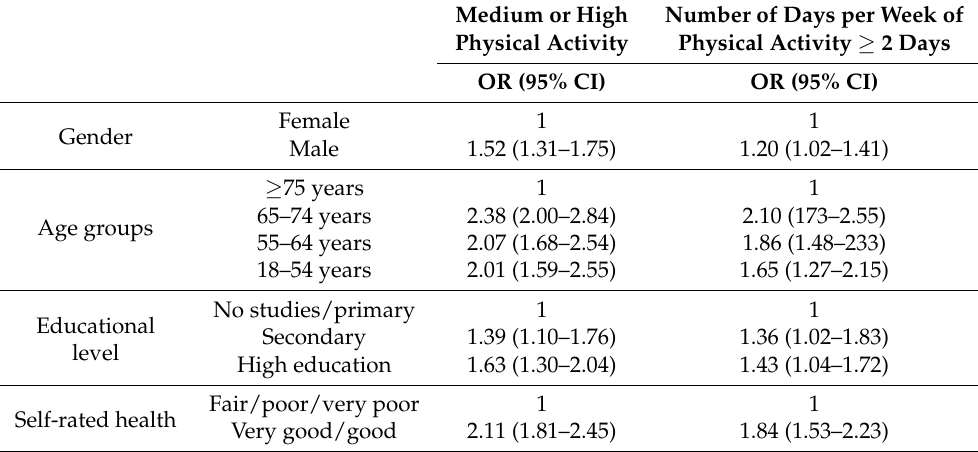
Table 4. Variables associated with medium or high physical activity and with number of days of physical activity ≥ 2 days among people with diabetes. Results of multivariable logistic regression